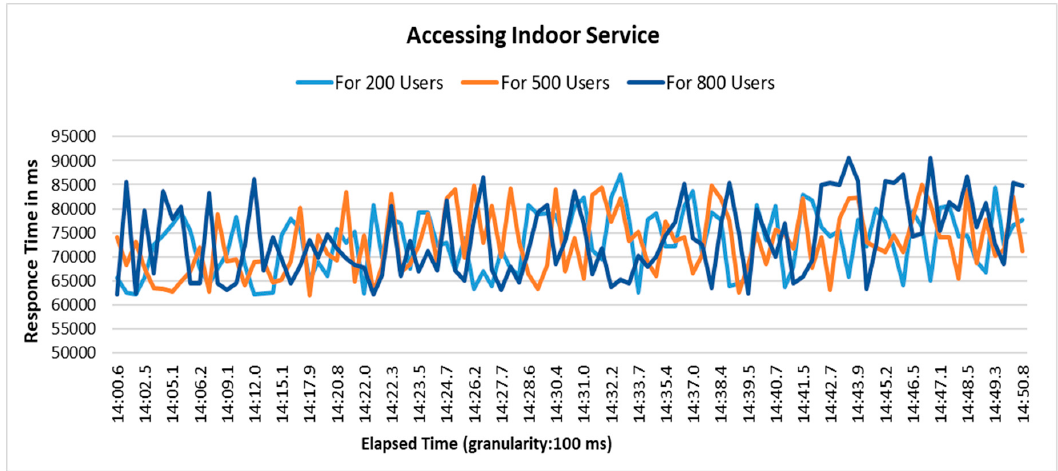
Figure 19. Accessing indoor service response time in the different simultaneous request.